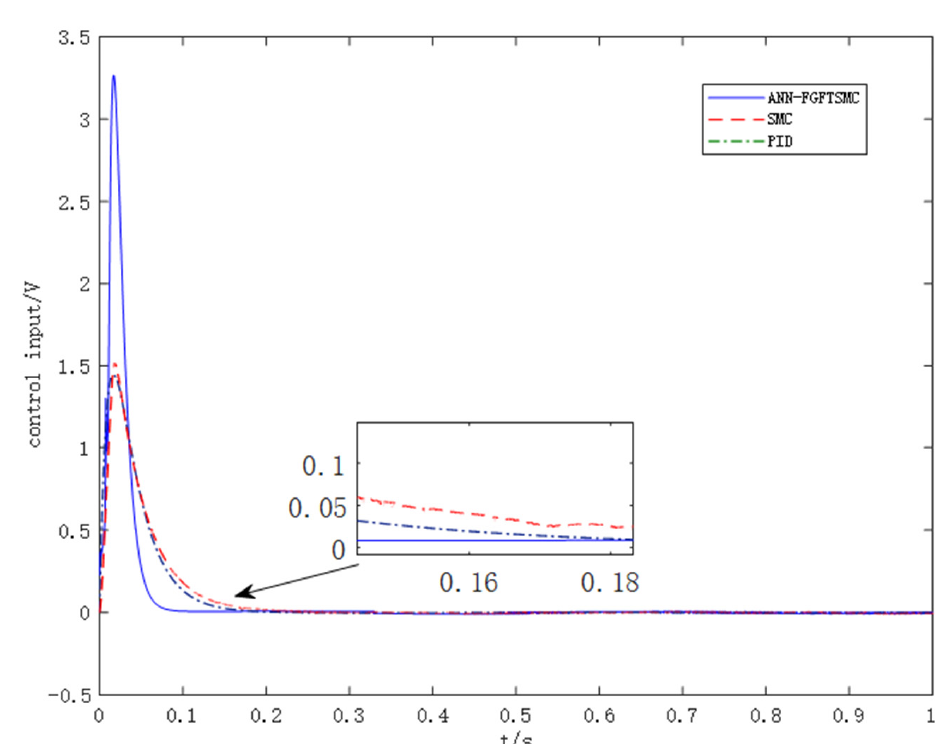
Figure 12. Control input curves of three controllers